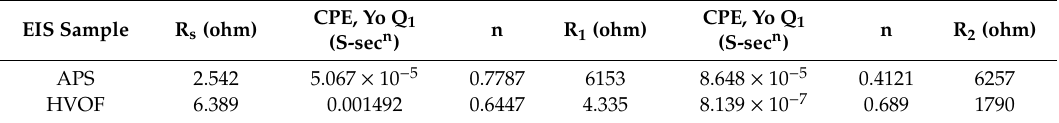
Table 4. EIS-calculated values of equivalent circuit Zsim 3.20 software.